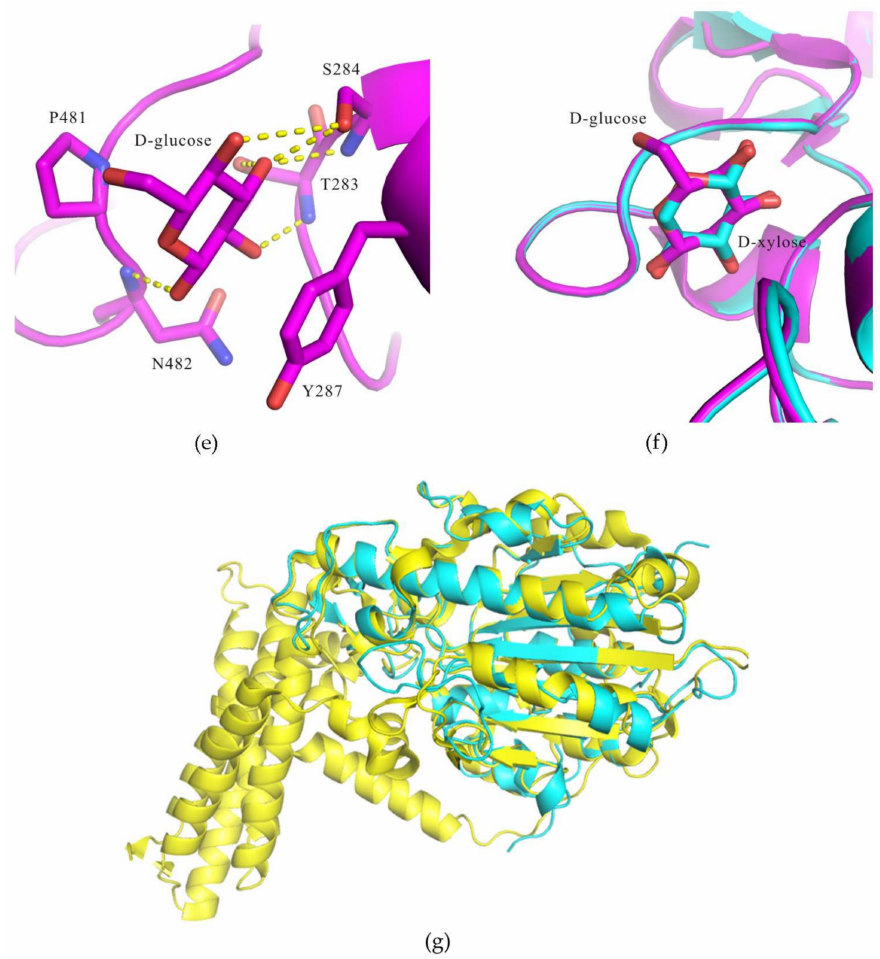
Figure 4. Structure of the cMCR-1- D -xylose complex. ( a ) The ribbon diagram showing the overall structure of cMCR-1. ( b ) The Fo-Fc electron-density map contoured at 3.0 σ depicting the D -xylose molecule. The map was calculated using the model omitting the D -xylose molecule after rounds of refinement. ( c ) The 2Fo-Fc electron-density map contoured at 1.0 σ depicting the D -xylose molecule. ( d ) Interaction between cMCR-1 and the D -xylose molecule. ( e ) Interaction between cMCR-1 and the D -glucose molecule. ( f ) Superposition of cMCR-1- D -xylose (cyan) and cMCR-1- D -glucose (magenta). ( g ) Superposition of cMCR-1- D -xylose (cyan) and EptA (yellow). All figures were prepared using PyMOL